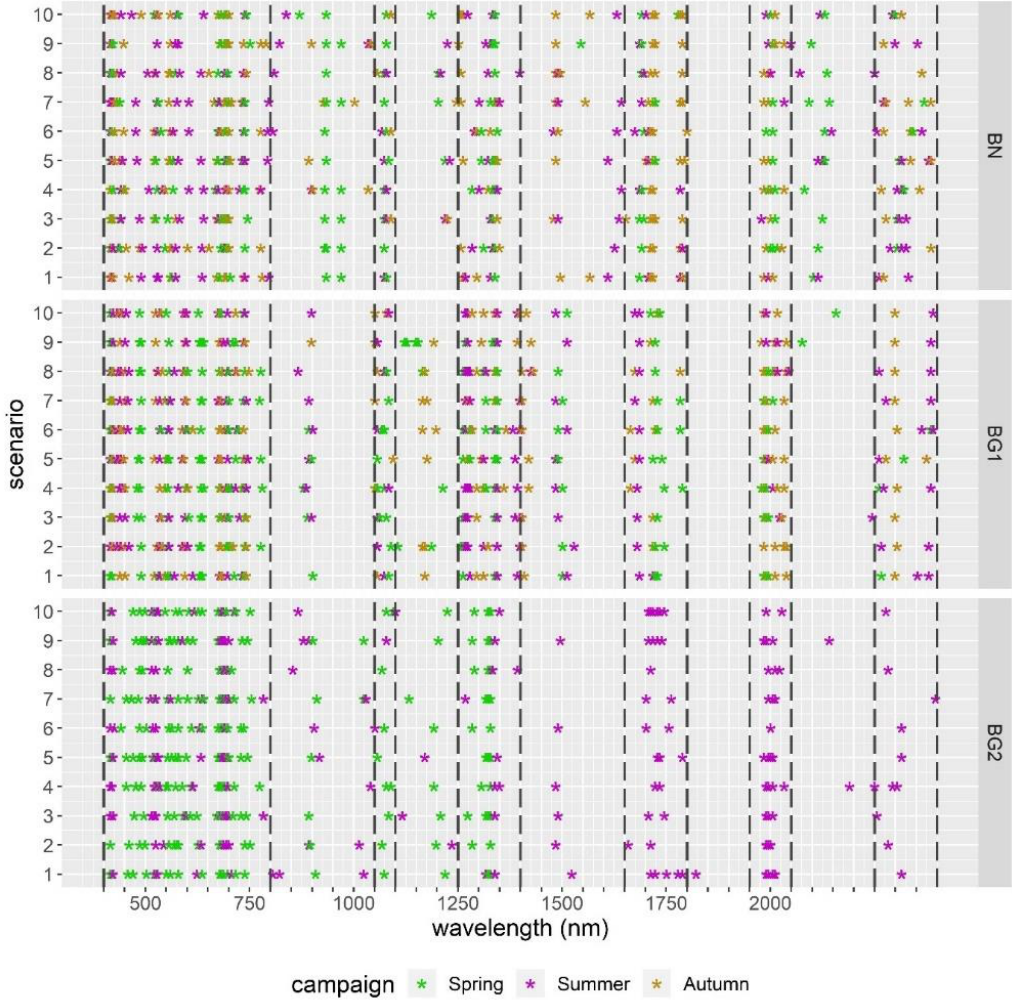
Figure 7. Results of Exp. 1a: features selected by RFE, as a result of the ten classification runs on the 430 SR bands, for each study area and acquisition campaign. Dashed lines represent the mostly used spectral ranges.